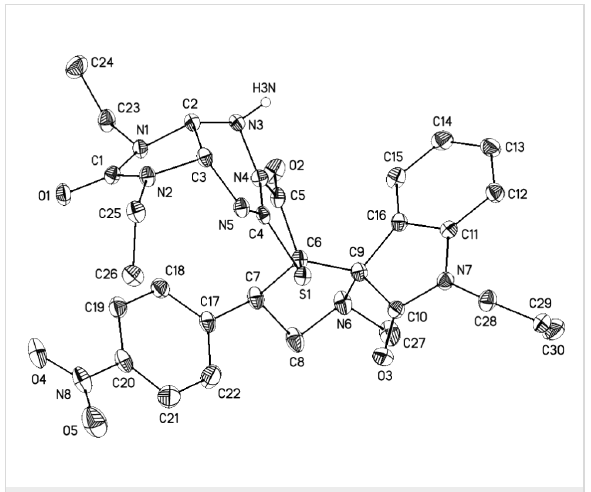
Figure 7: General view of 4r in the crystal in thermal ellipsoids repre- sentation (50% probability). Hydrogen atoms connected to carbon atoms are omitted for clarity.